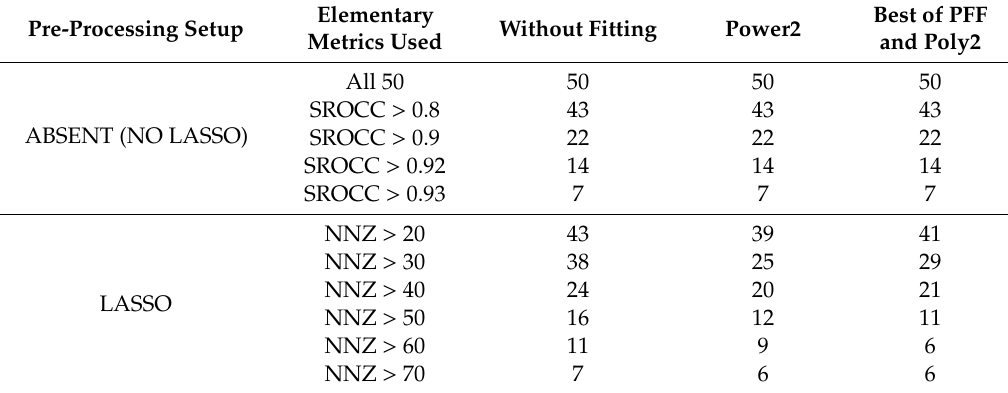
Table 4. The numbers of elementary metrics used as the inputs for di ff erent configurations of neural networks (NN)s under conditions of di ff erent fitting and restrictions imposed on an elementary metric set.